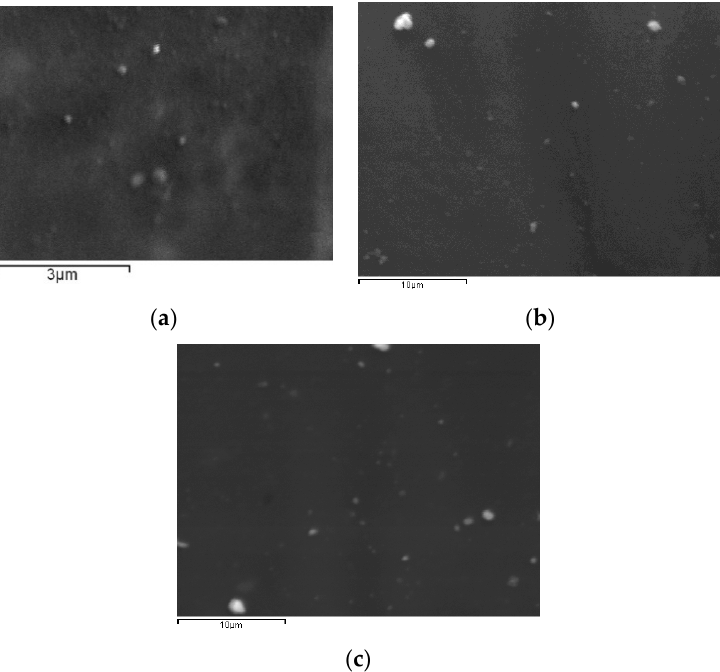
Figure 2. SEM micrographs of CS/TPP 2/1 nanoparticles of CS/TPP 2/1 nanoparticles prepared at different stirring rates: (a) 400 rpm, (b) 800 rpm and (c) 1200 rpm.